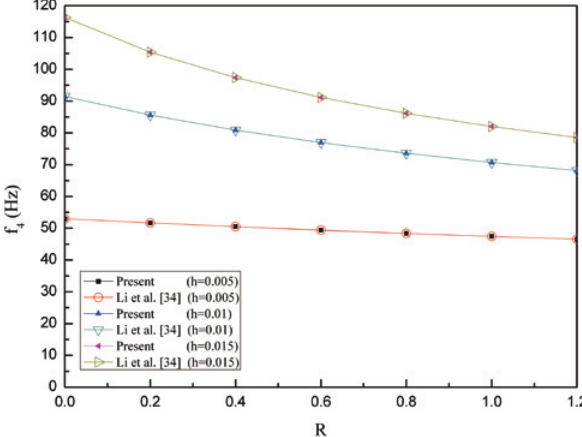
Figure 4 The first-order frequency of the clamped square compos- ite laminates with uniform bonding imperfections.